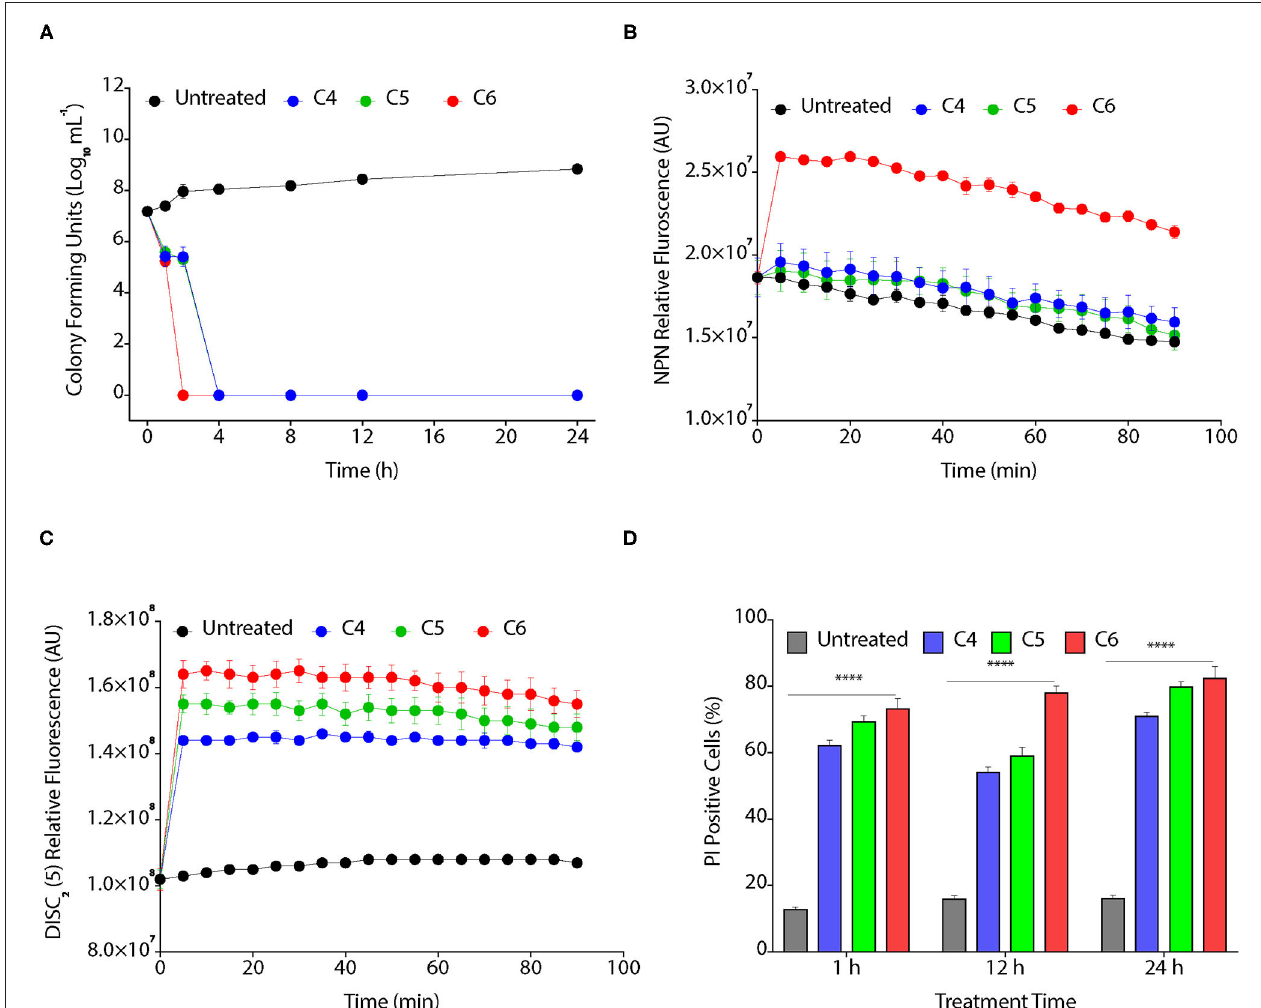
FIGURE 2 | CAGCs affect bacterial membranes. (A) Time kill assay on the treatment of Xoo with 8 µ g/ml of C4, C5, and C6 CAGCs. (B) Time-dependent change in fluorescence of N -phenyl-1-naphthylamine (NPN) in presence of different CAGCs. (C) Change in fluorescence intensity of 3, 3 ′ -diethylthiadicarbocyanine iodide (DiSC 2 ) (5) over time after treatment of Xoo with different CAGCs. (D) Percentage of PI positive Xoo cells at a different time on treatment of Xoo with 8 µ g of different CAGCs . The NPN and DISC 2 (5) fluorescence were measured at λ ex of 350nm, λ em of 420nm, and λ ex of 637nm, λ em of 670nm by spectrophotometry. The number of Xoo live cells with response to CAGCs were measured using FACS. Error bars indicate that experiments were repeated a minimum of three times with four biological replicates. ( α = 0.05, **** p < 0.0028). Significant differences were determined by using one-way ANOVA with Tukey’s HSD analysis.